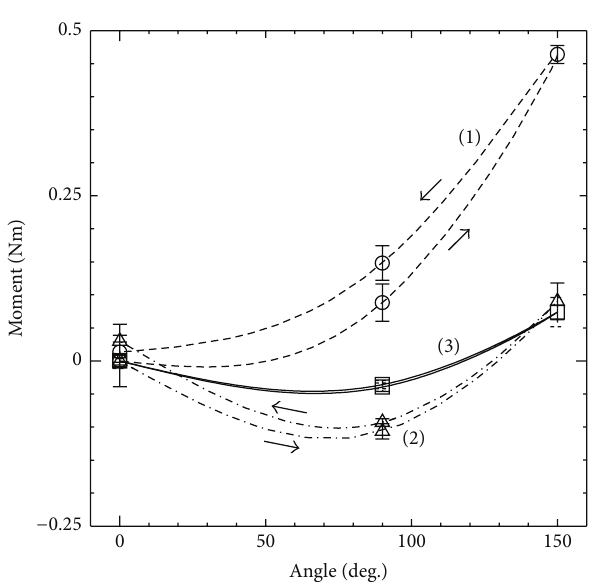
Figure 20: Bending moment on knee